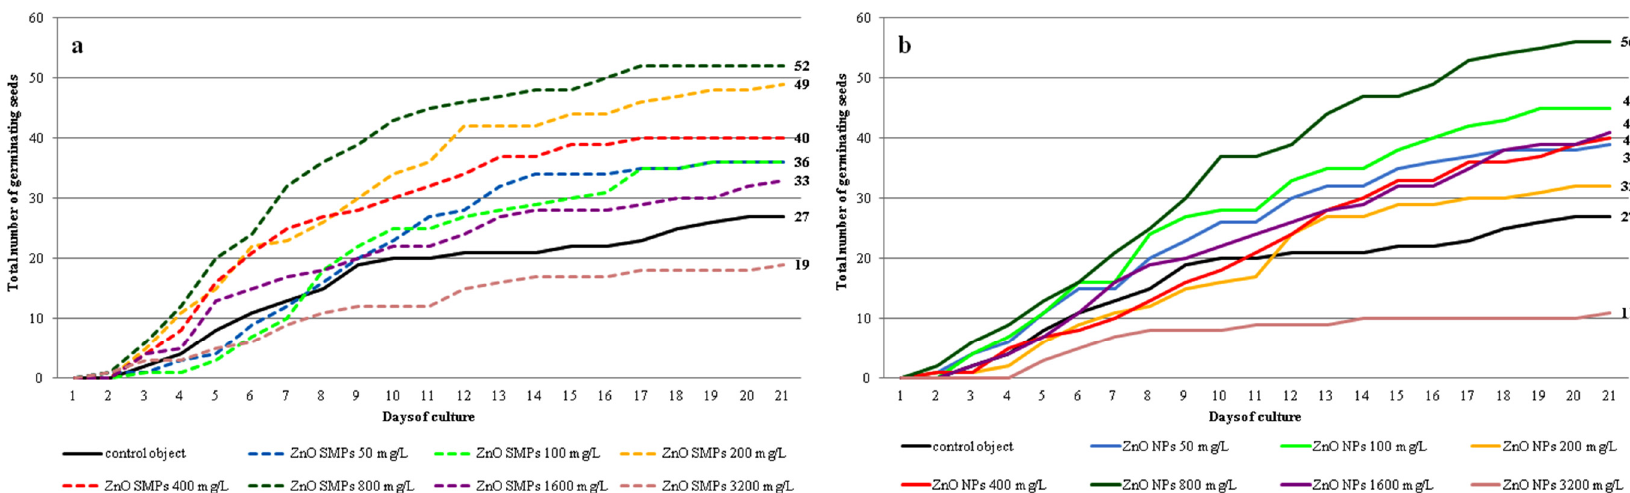
Figure 5. Dynamics of Allium cepa L. ’Sochaczewska‘ seed germination on the modified MS medium depending on ZnO SMPs (a) or ZnO NPs (b) treatment.